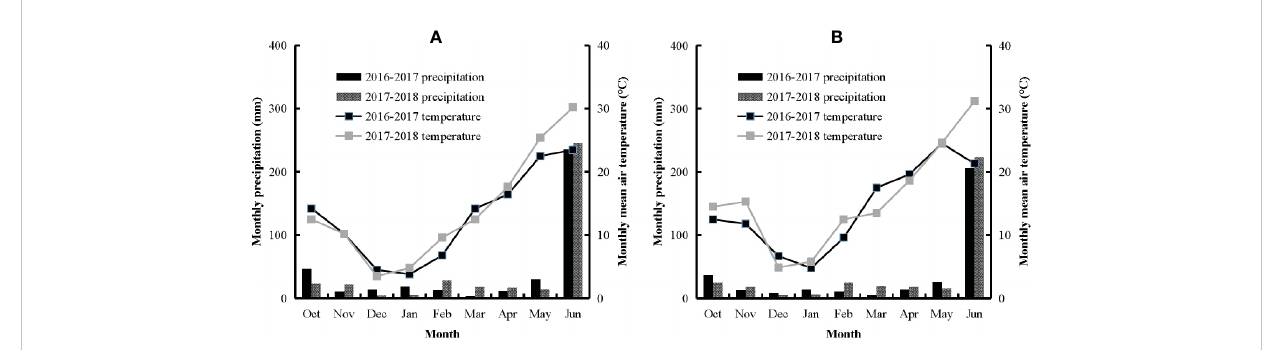
FIGURE 1 Monthly mean air temperature (°C) and precipitation (mm) from 2016 to 2018 seasons at different experimental sites (A) Xinxiang (XX); (B) Jiaozuo